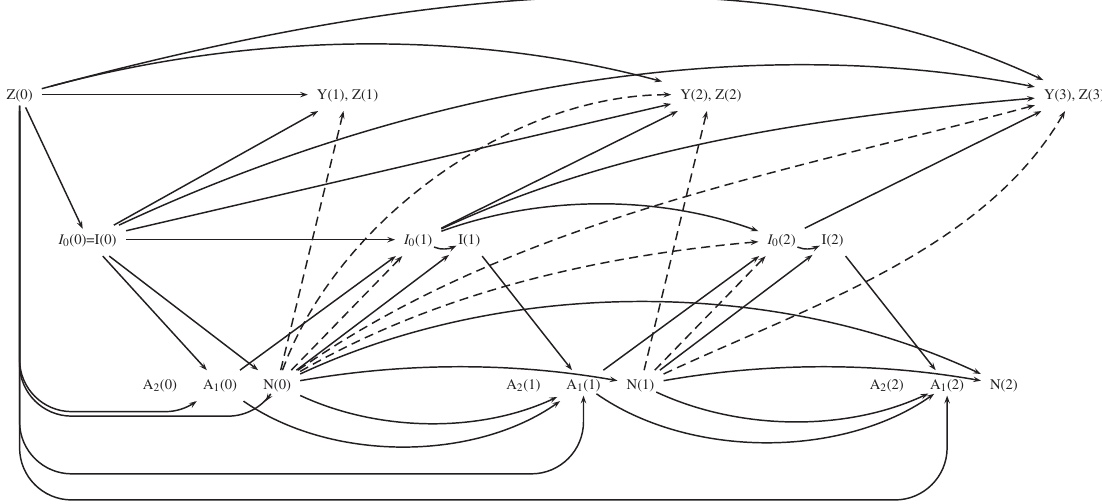
Figure 1: Example of a Directed Acyclic Graph consistent with the general NPSEM introduced in Section 3. This graph assumes, in particular, that all disturbances are mutually independent, that the nodes Y ð t Þ and Z ð t Þ share the same parents (with t =1,2), and that right-censoring is completely at random. The exclusion of the arrows represented with dashed lines in this diagram graphically encodes the upholding of the NDE assumption introduced in Section